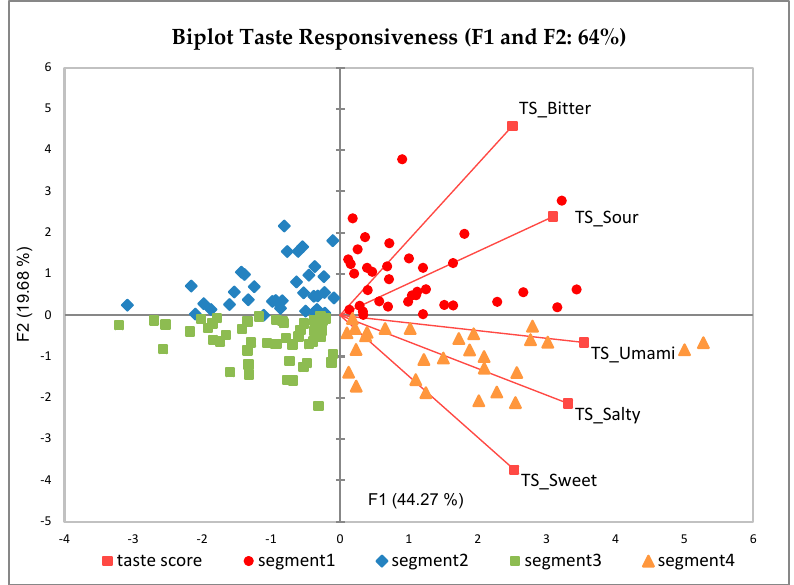
Figure 2. Children’s segmentation according to taste scores. Different colors and symbols indicate different segments (TS= Taste score)